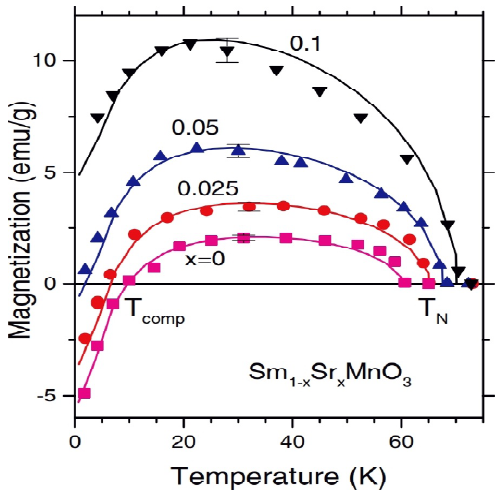
Fig. 11. Temperature dependent spontaneous mag- netization for Sm Sr MnO crystals, experiment x 3 1– x (points) and theory (solid lines). Reproduced from [68] with permission from AIP